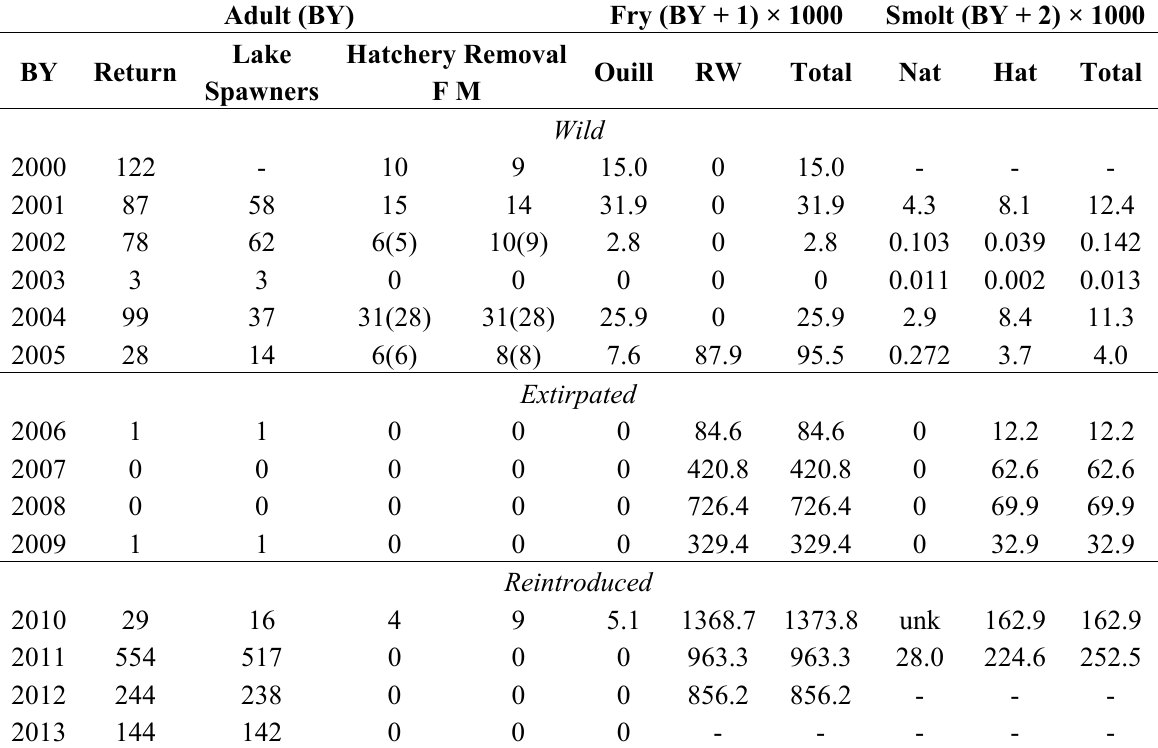
Table 2. Numbers of adult sockeye salmon that returned to Sakinaw Lake each broodyear (BY), including those removed as male (M) and female (F) Ouillet hatchery broodstock, and the number estimated to spawn naturally in Sakinaw Lake. The numbers of Ouillet and Rosewall hatchery fry (in thousands) released into the lake in the following year (BY + 1), and the numbers of natural and hatchery smolts (in thousands) emigrating from the lake after two years (BY + 2) are also shown. Zeros indicate no fish; dashes indicate no data. Unk indicates an unknown number of natural smolts were included in the hatchery smolt total because there was no clipping of hatchery juveniles from that year. Numbers in parentheses indicate wild Sakinaw parents from which fertilized eggs were used to found the captive breeding program at Rosewall